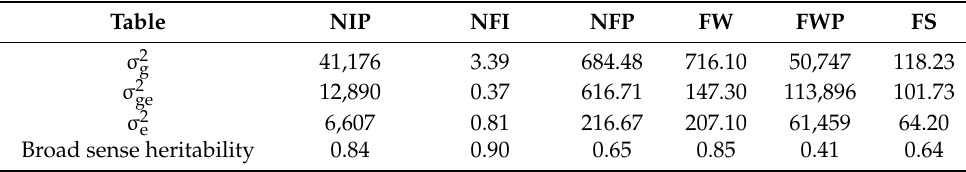
Table 3. Estimated variance components for the traits across